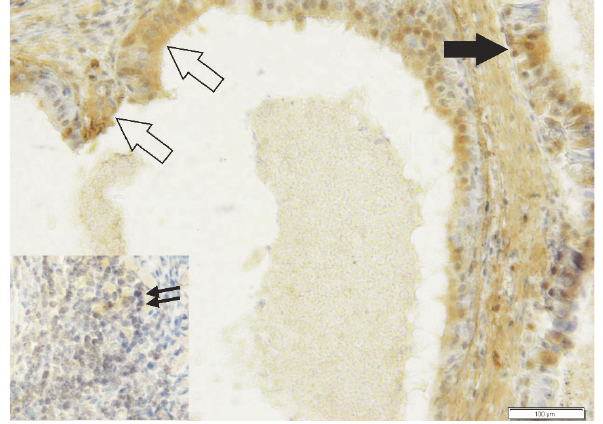
Fig. 3. Oncocytoma. Dilated D2-40 positive lymphatic vessel (black arrow) is present in the tumour capsule. Two smaller channels are placed in the parenchyma (white arrow), in which faintly stained myoepithe- lial cells (arrowhead) are scattered.